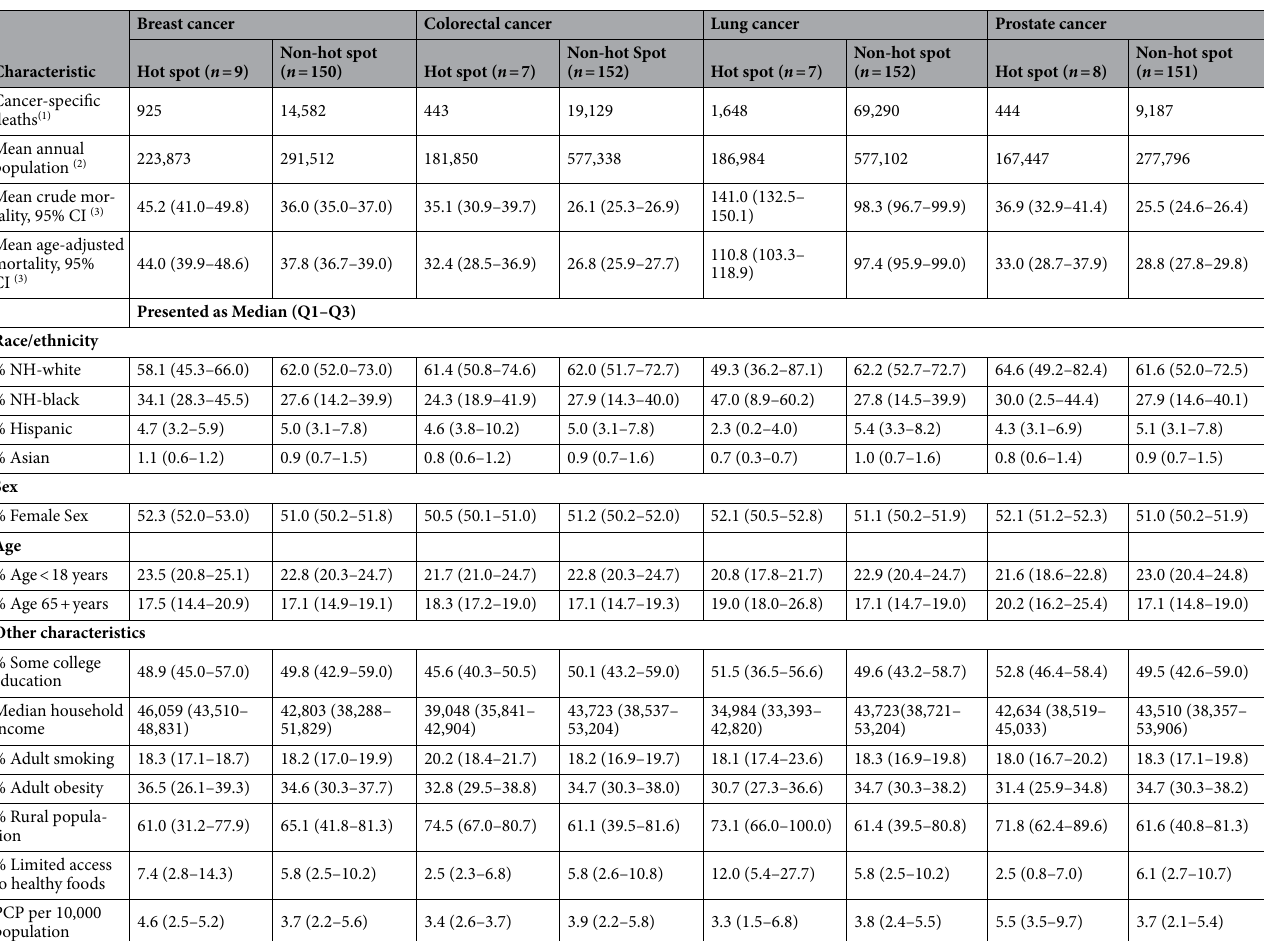
Table 2. Patterns of county-level community health risk factors and behaviors by cancer mortality hot spot classification, stratified by cancer types among non-Hispanic white adults in Georgia 1999 – 2019. (1) Total number of cancer specific deaths from 1999 through 2019. (2) Mean annual population for total period (1999– 2019) among counties within hot spot classification. For sex-specific cancers of breast and prostate, these mean population estimates are women and men, respectively. (3) Mortality rates are per 100,000 population. For sex-specific cancers of breast and prostate, they are per 100,000 women and men, respectively. 95% confidence limits presented with